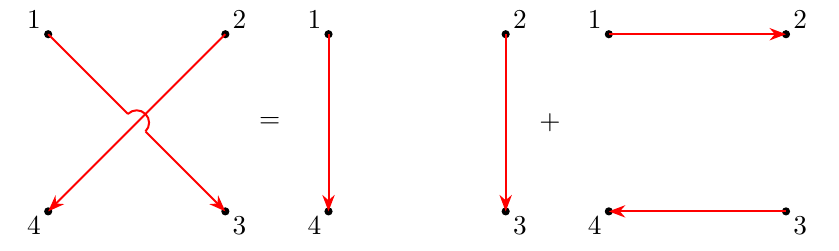
Figure 3 . Schouten identities are equivalent to untying crossings for both the two graphs in the multigraph: h 1 3 ih 2 4 i = h 1 4 ih 2 3 i + h 1 2 ih 3 4 i